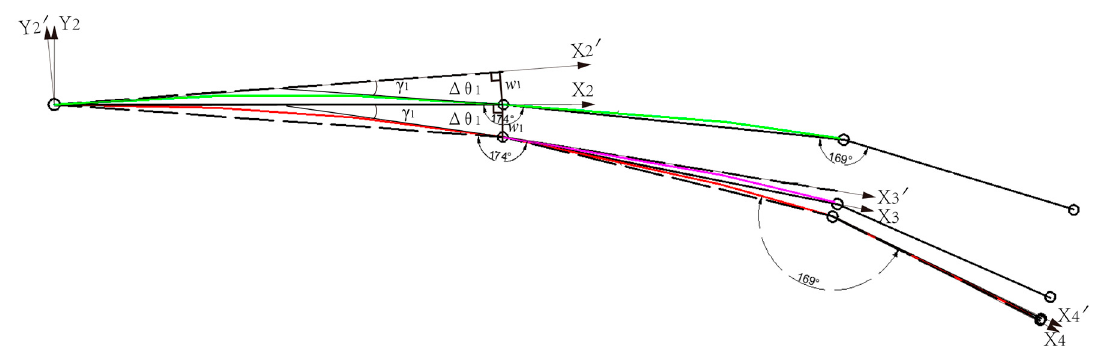
Figure 3. The basic principle of joint angle independent compensation.